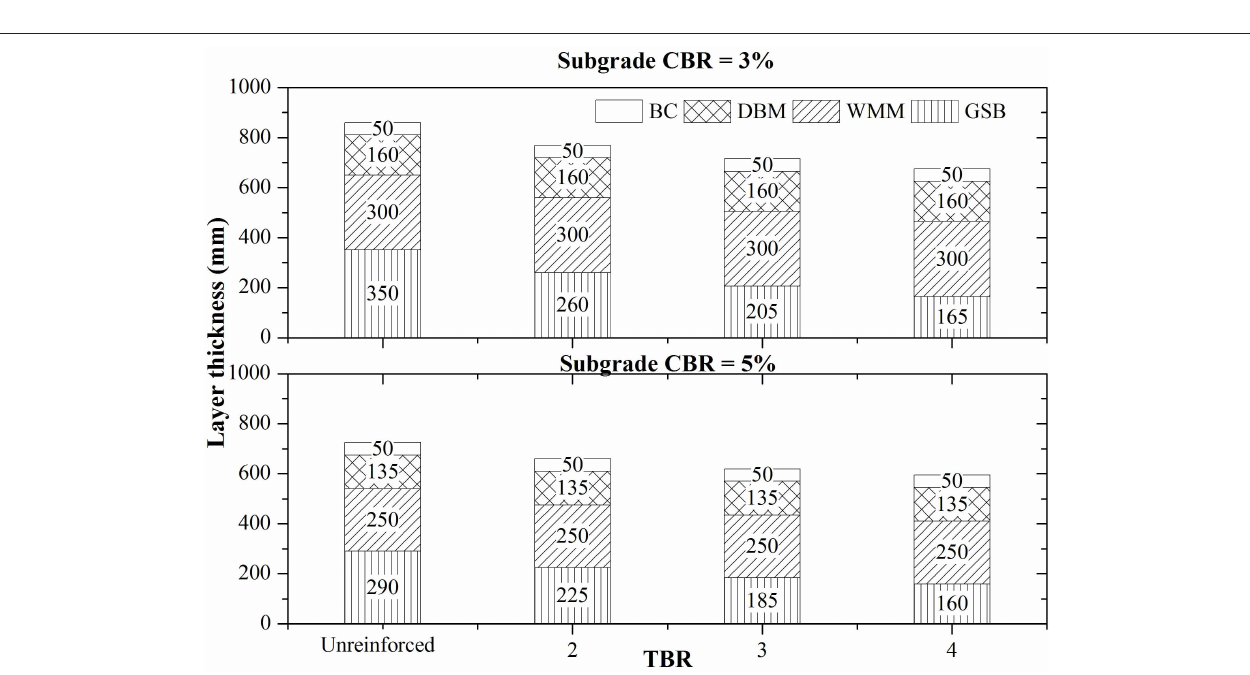
FIGURE 3 | Design charts showing thicknesses of unreinforced and geogrid-reinforced flexible pavements using TBR approach based on Objective-1 for the traffic of 100 MSA with subgrade CBRs equal to 3 and 5%.